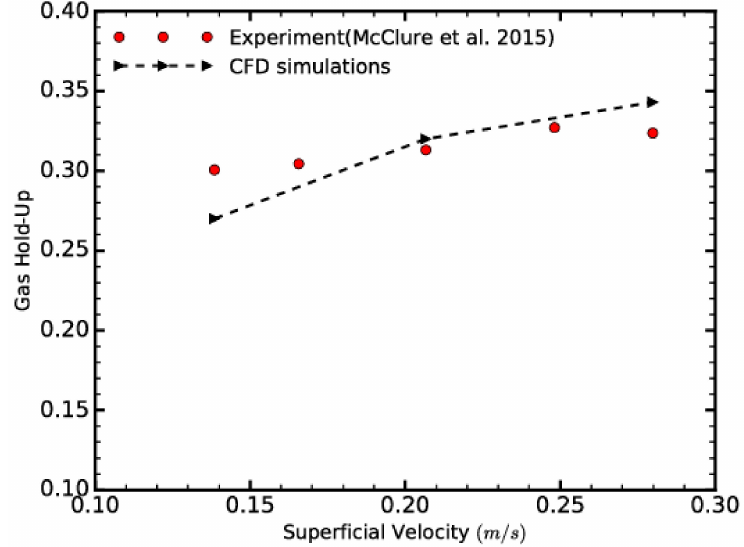
Figure 3. Hold-up of air in water in a bubble column for different superficial velocities. Comparison of the present calculations with the experiments of [31].